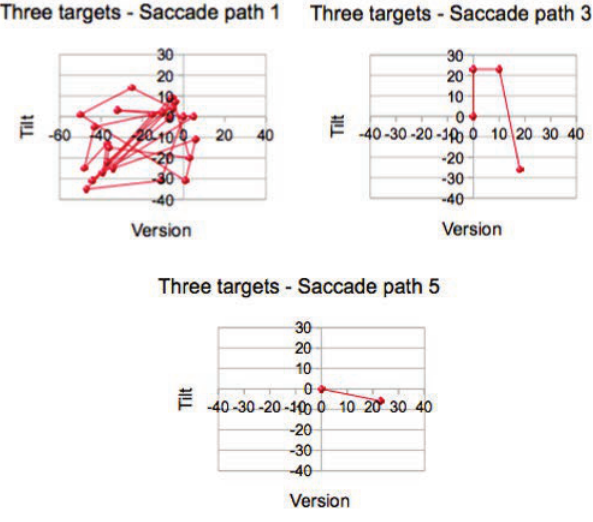
Figure 6. Motor movements for fixating on three targets. Movement tracks are takenfromsaccades1, 3and5showingtherapidearlydevelopment. Movements are relative to the target location.